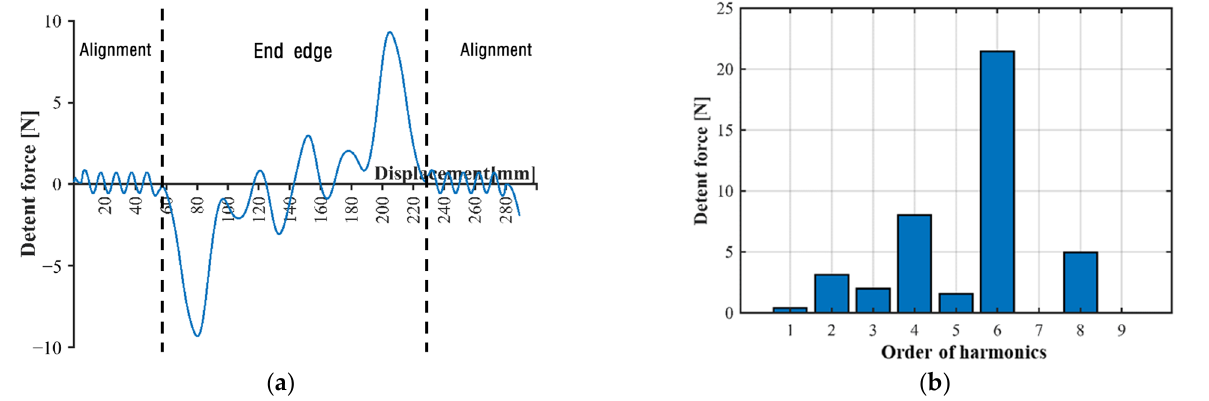
Figure 3. FEM result of detent force at no load: ( a ) Detent force caused by end effect; ( b ) Harmonic components of detent force.